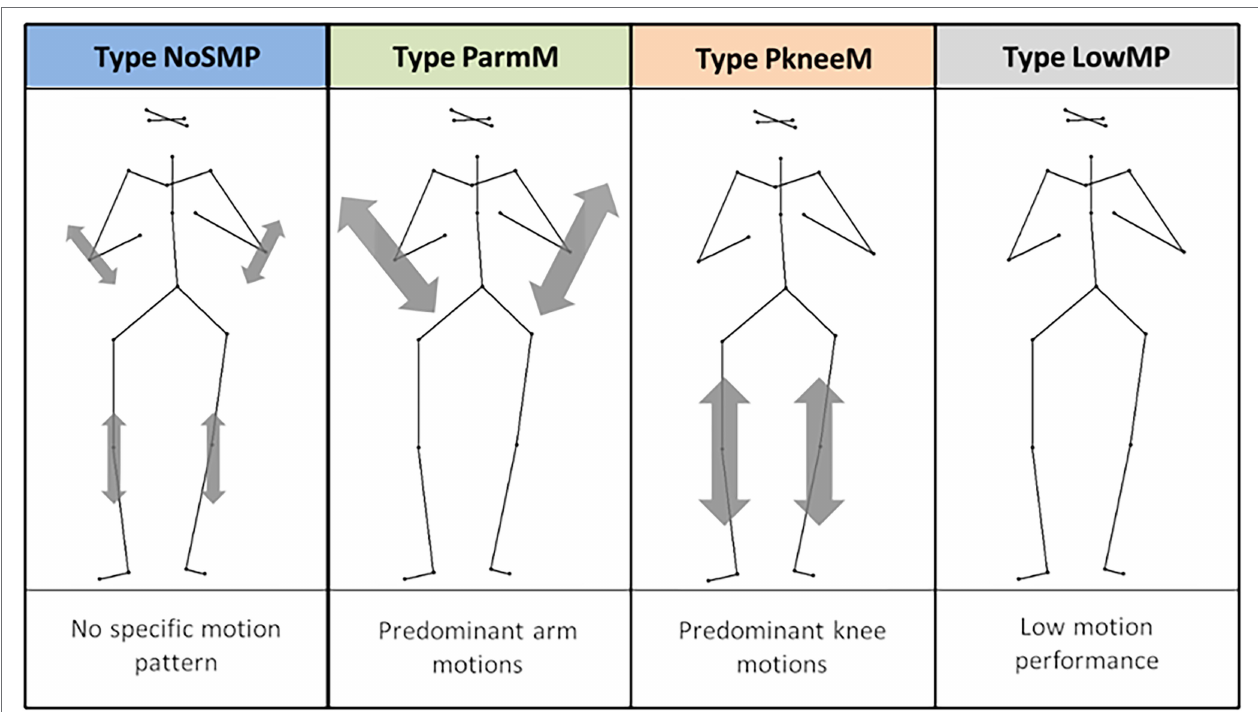
FIGURE 1 | Motion types of clarinetists found in Weiss et al.